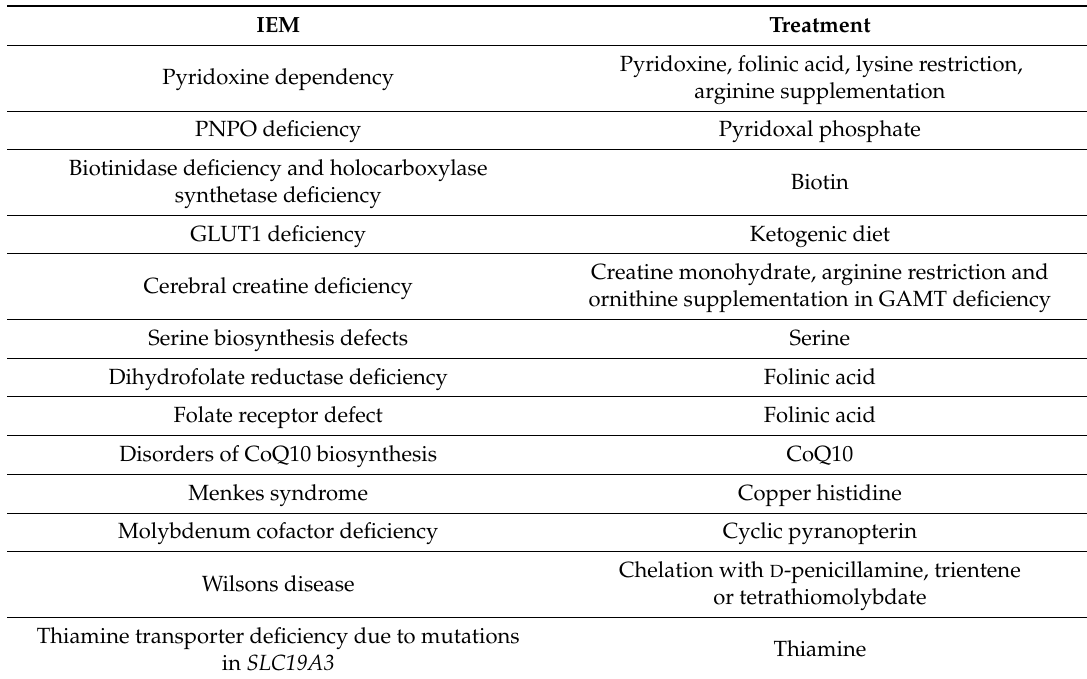
Table 6. Specific treatments for IEM associated with epilepsy